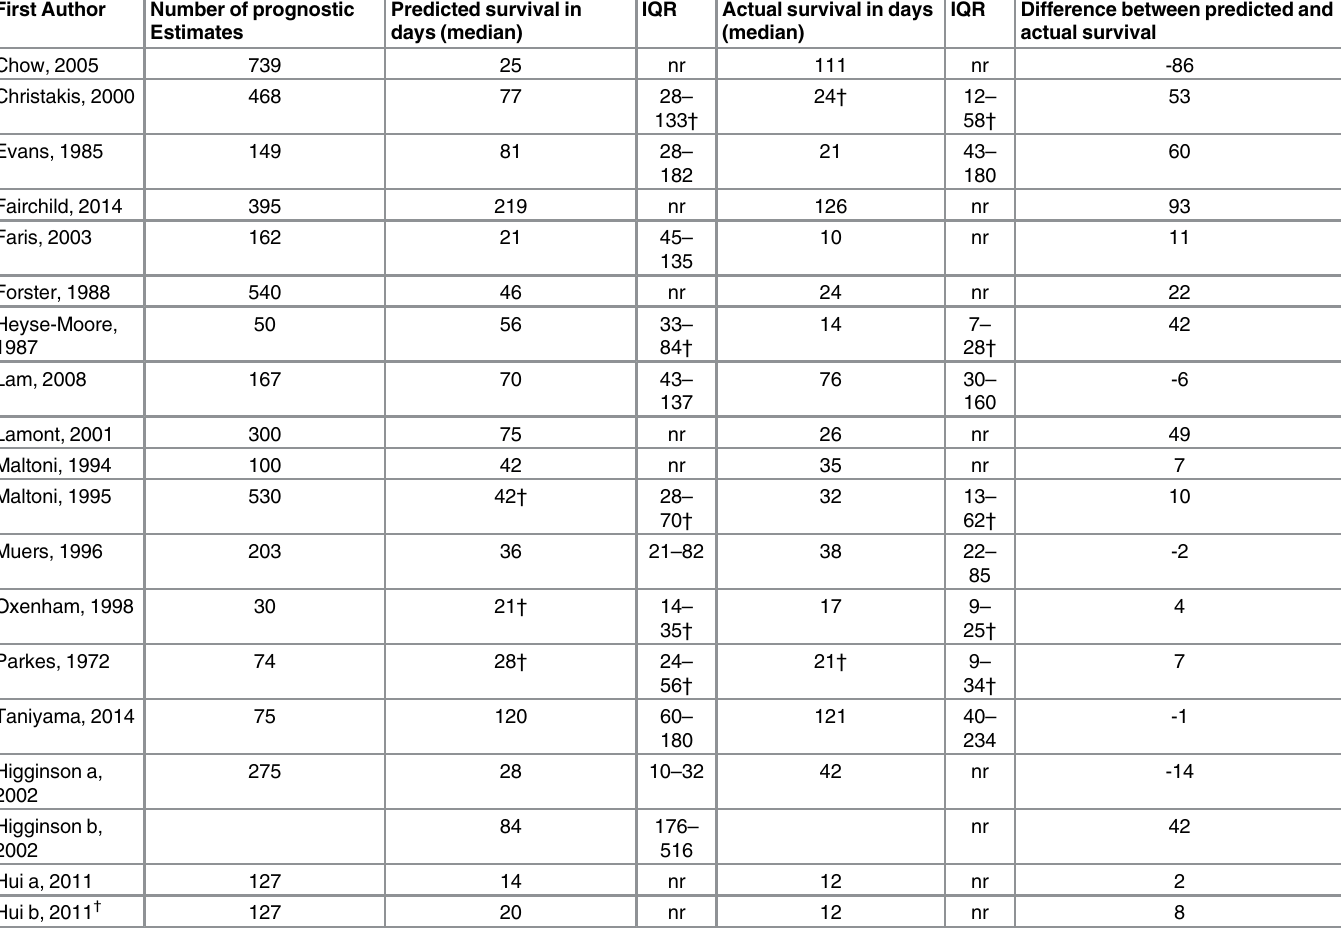
Table 3. Predicted versus actual survival in those studies where clinicians were asked to provide a continuous temporal estimate of survival (con- tinuous